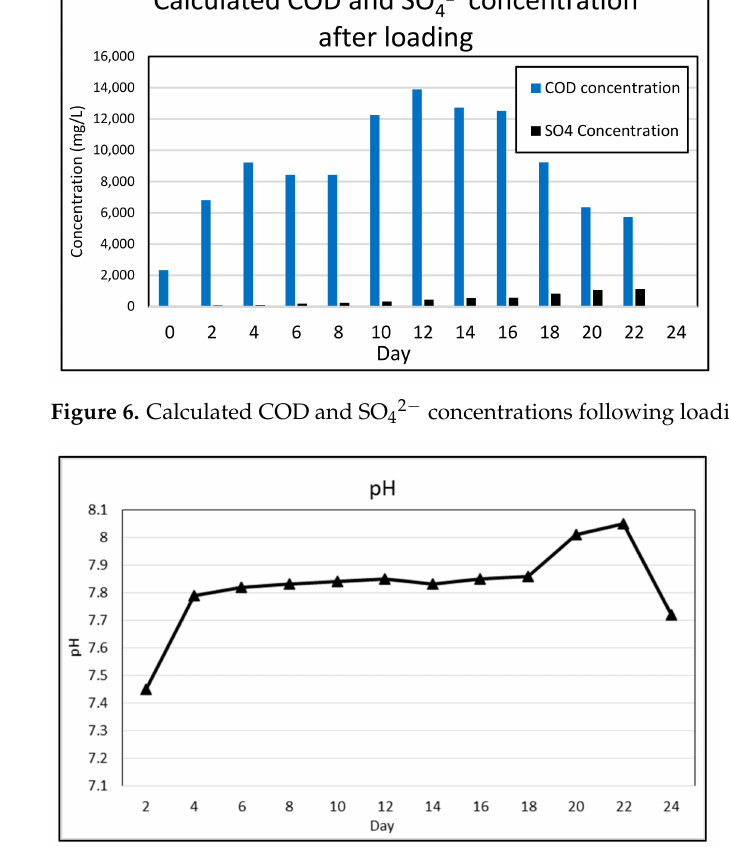
Figure 7. pH readings at 48 h intervals from loading.